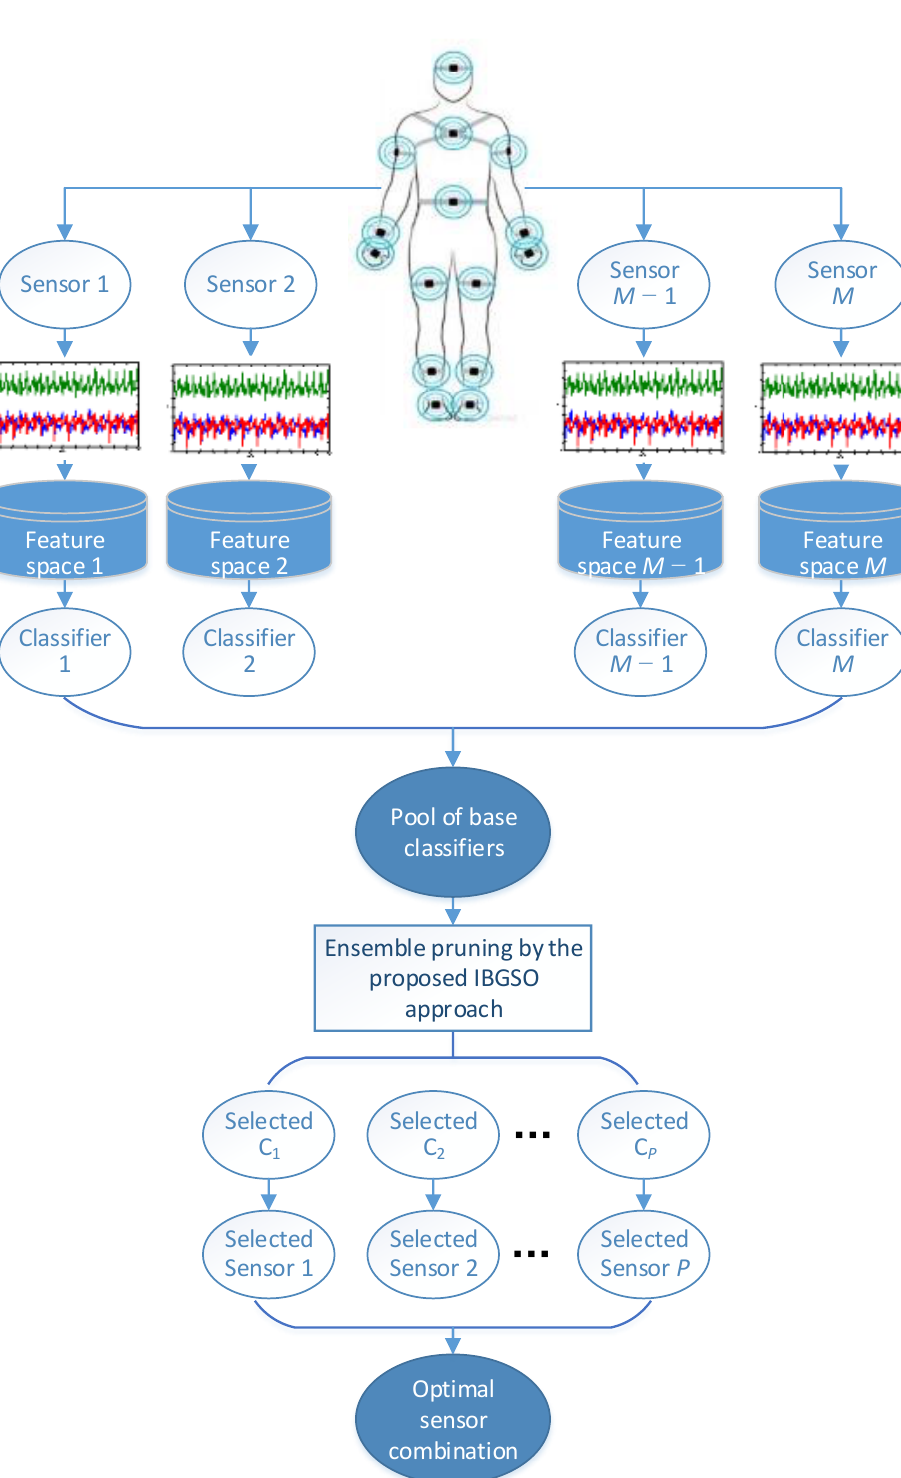
Figure 4. The framework of multi-sensor-based human activity recognition (HAR) with an improved binary glowworm swarm optimization (IBGSO) selective ensemble.